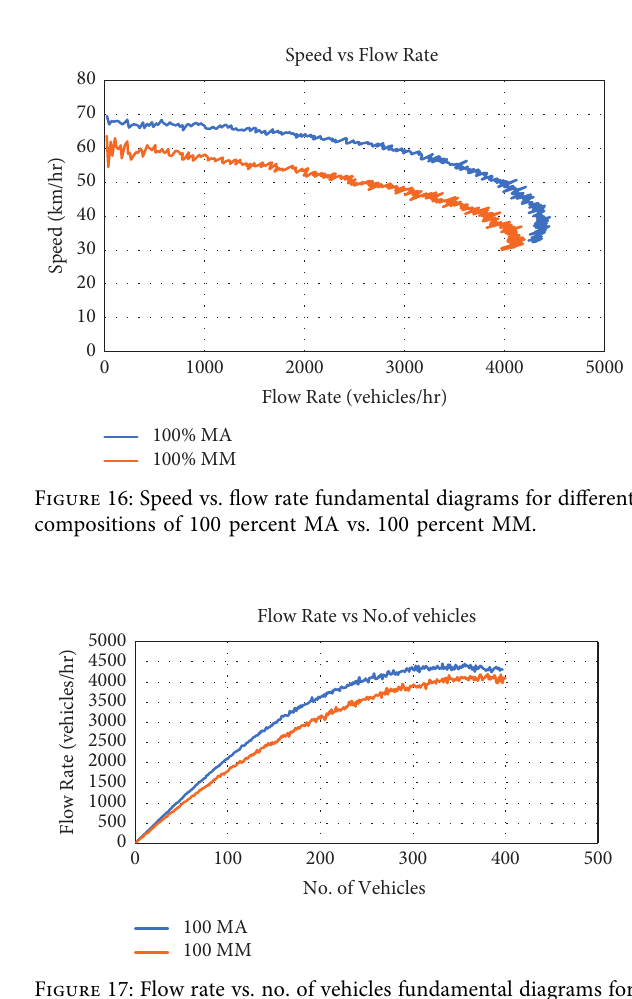
Figure 15: Speed vs. density fundamental diagrams for different compositions of 100 percent MA vs. 100 percent MM.